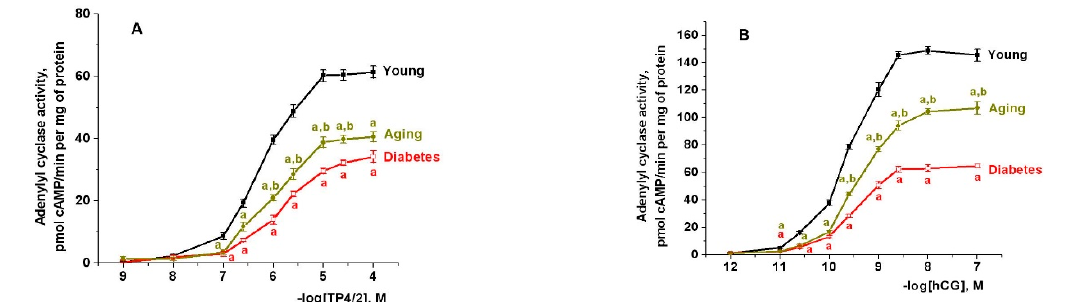
a —the difference between the group Young+dmso and the other groups with the treatment DMSO or TP4/2+DMSO or between the group Young+saline and the other groups treated with saline or hCG+saline is significant at p < 0.05; b —the difference between aging/diabetic rats without TP4/2 or hCG administration and aging/diabetic rats with TP4/2 or hCG administration is significant at p < 0.05. In each group n = 5, M ± SEM.